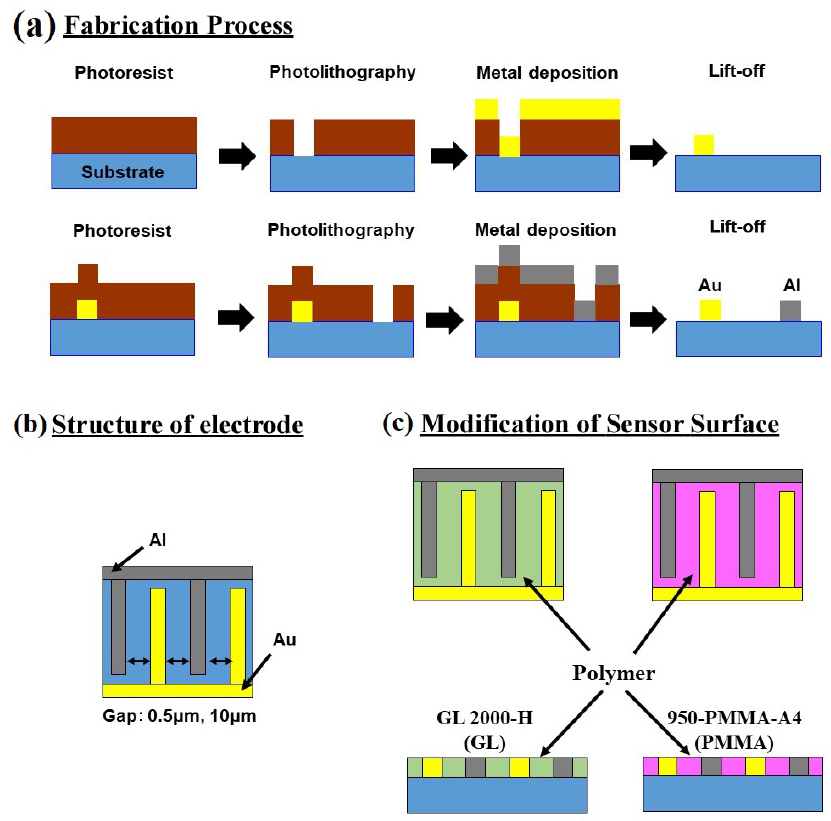
Figure 1. ( a ) Schematic flow of fabrication process of sensor with arrays of Al and Au electrodes on the sensor surface, ( b ) structure of electrodes and ( c ) modification of sensor surface by introduction of polymer PMMA and GL coatings onto the surface of the sensor (between the electrodes).